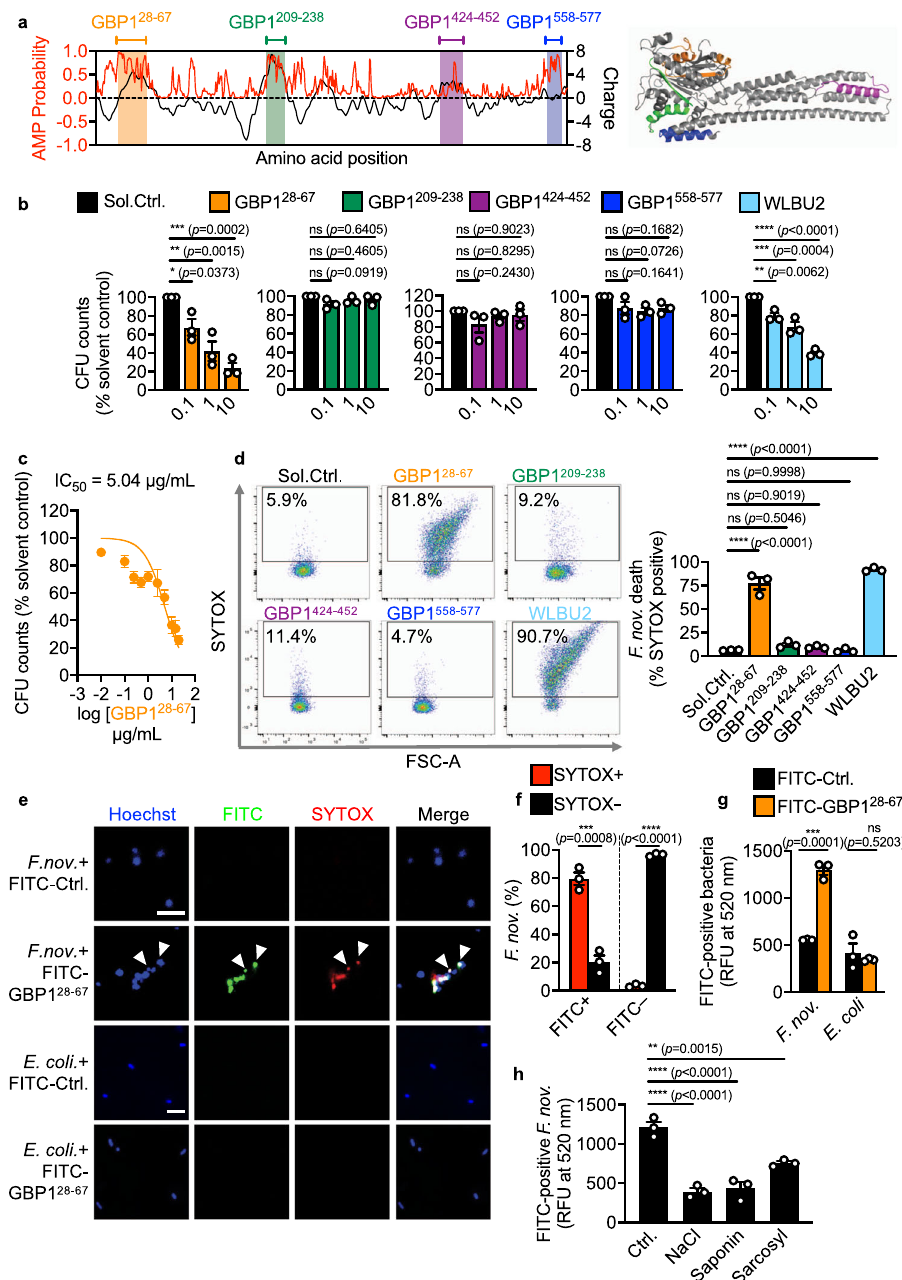
Fig. 3 | GBP1peptidebinds toand kills F.novicida . a Analysisof AMP probability (red) and charge (black) for the mouse GBP1 protein sequence and illustration of the location of putative antimicrobial stretches within the predicted mouse GBP1structure. b Viabilityof F.novicida [ F.nov .,aspercentageofCFUinrelationto solvent control (Sol.Ctrl.)] assessed 6h after incubation with GBP1 28 – 67 , GBP1 209 – 238 , GBP1 424 – 452 ,GBP1 558 – 577 orWLBU2at0.1,1or10 μ g/mL. c Viabilityof F.nov .following incubation with GBP1 28 – 67 for 6h over a concentration range (0.01 – 20 µ g/mL) to determine the half maximal inhibitory concentration (IC 50 ). d Flow cytometric analysis (left) and quantitation of fl ow cytometry plots (right) of SYTOX stained F. novicida treated with Sol.Ctrl. or 100 μ g/mL of GBP1 28 – 67 , GBP1 209 – 238 , GBP1 424 – 452 , GBP1 558 – 577 or WLBU2 for 12h. e Confocal microscopy analysis of Hoechst-stained totalbacteria(blue),FITC-GBP1 28 – 67 (green)andSYTOX(red)in F.novicida or E.coli